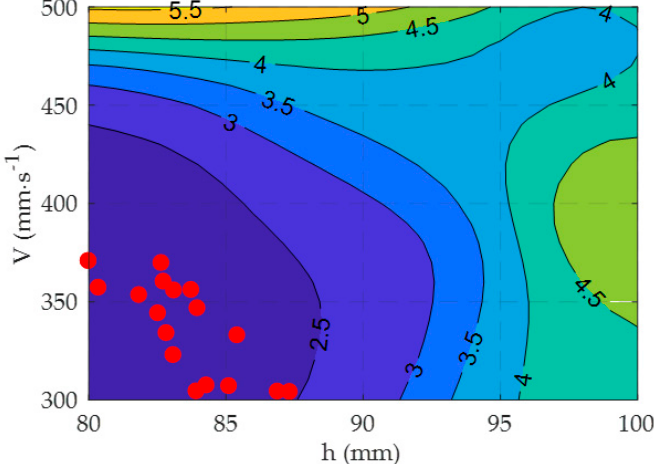
Figure 11. Contour plot of the function P (h, V) with optimal solutions (red dots).